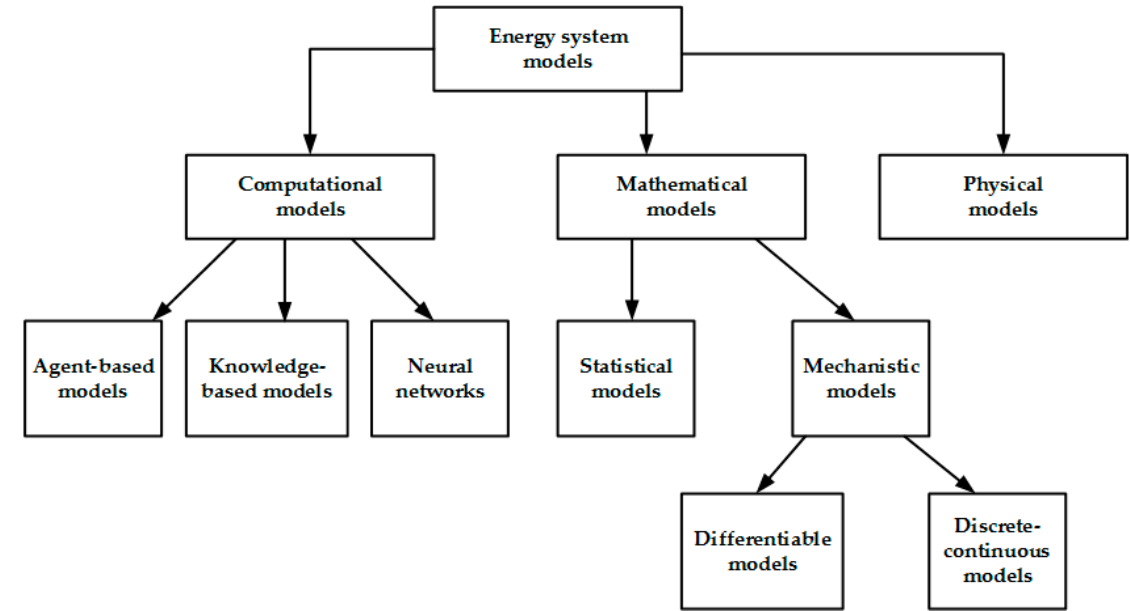
Figure 1. Taxonomy of energy systems modeling proposed by Subramanian et al. [1]. Reproduced with permission from MDPI.